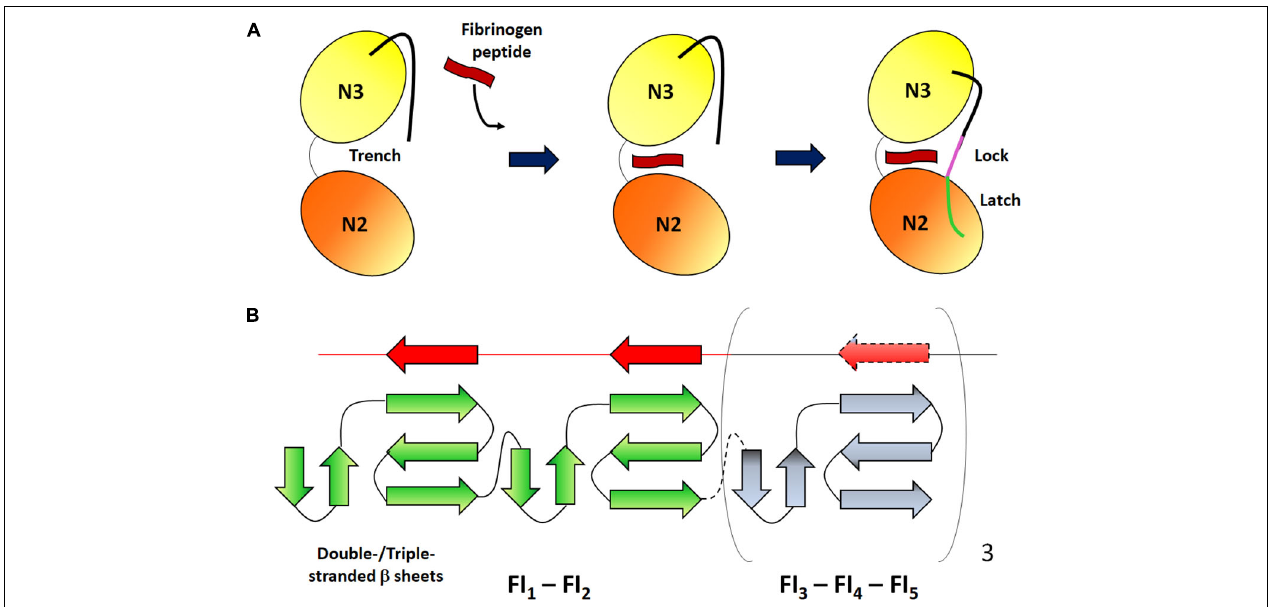
FIGURE 3 | Schematic representation of the binding mechanisms of Fbg and Fn. (A) Dock, lock and latch mechanism. The N2 and N3 subdomains of the MSCRAMM form a open trench where a Fbg peptide (red) can be inserted. After ligand binding, the C-terminal unstructured extension of the N3 subdomain undergoes conformational changes so that the segment covers the bound peptide and locks it in place (magenta) and binds to a β -strand in the N2 subdomain (green). Adapted from Geoghegan and Foster, 2017. (B) Tandem β -zipper mechanism. The Fn-binding repeats form a disordered region between the A domain and the C-terminal end of FnBPs. Each linear repeat (red) can complex with the type I modules (green) of the N-terminal domain forming additional short β -strands and extending the triple-stranded β -sheet on each module. Adapted from Matthews and Potts (2013).